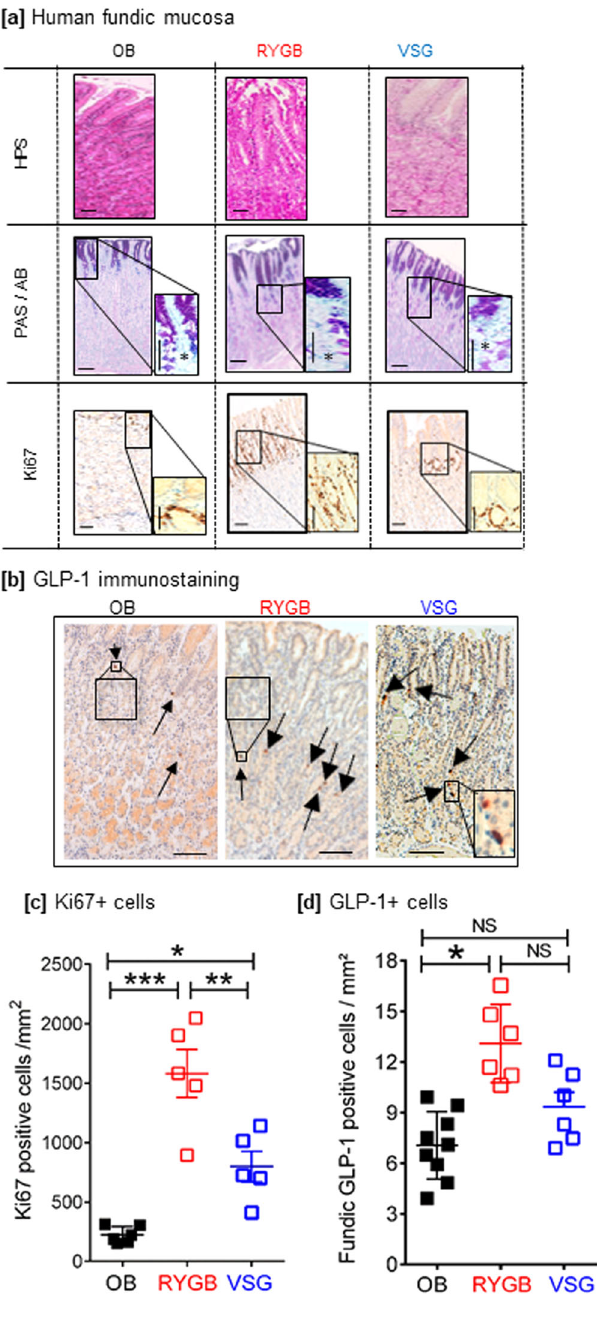
Fig. 3 Bariatric surgery induces remodeling of gastric mucosa in humans. a Histological gastric mucosa phenotype before and after bariatric surgery in humans. Representative photomicrograph of HPS staining, Periodic Acid Schiff/Alcian blue (PAS/AB), and Ki67 immunostaining (brown nuclei) in fundic mucosa section from non-operated obese subjects (OB) vs. obese individuals that underwent RYGB or VSG surgery. Note, in VSG and RYGB vs. OB subjects, the increase in pit depth and hyperplasia of the surface mucous cells, the increase prominence of PAS-positive cells (that stain neutral mucin) in the neck region of the glands (asterisks in high magni fi cation), and the higher Ki67-positive proliferative cells in the fundic mucosa. Bar scale 100 µ m. b GLP-1 immunostaining in human fundic mucosa. Representative photomicrograph (arrows) of GLP-1-positive cells in fundic mucosa section from obese subjects vs. obese individuals who underwent RYGB and VSG surgery. Bar scale 100 µ m. Quanti fi cation of Ki- 67 proliferative cells ( c ) ( n = 6 for OB, n = 5 for RYGB and VSG) and of GLP-1 immunoreactive cells ( d ) per mm 2 in the fundic mucosa of obese subjects (OB n = 9) and subjects operated on VSG ( n = 6) or RYGB ( n = 6). The data are presented as scatter data plots (each point represents one individual) with mean ± SEM and analyzed by one-way ANOVA followed by Tukey ’ s multiple comparison test. * P < 0.05, ** P < 0.01, and *** P < 0.001 and NS not signi fi cant. Source data are provided as a Source data fi